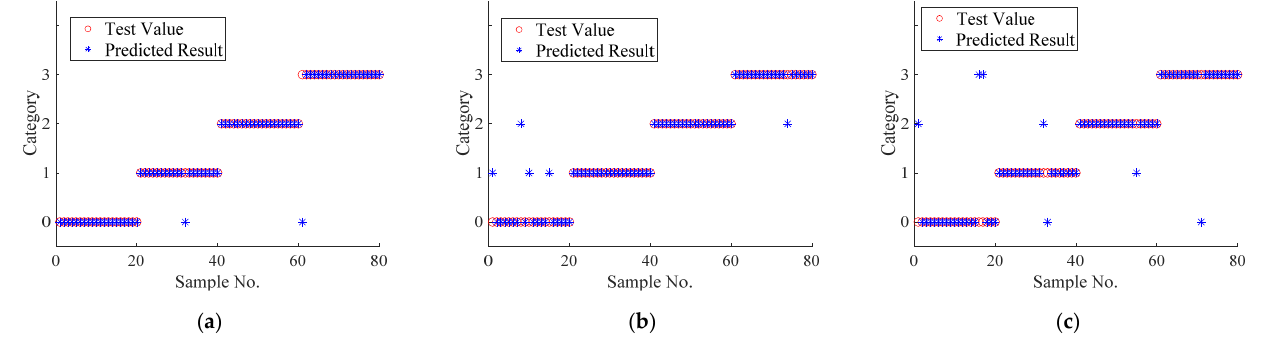
Figure 10. Parameter optimization results.